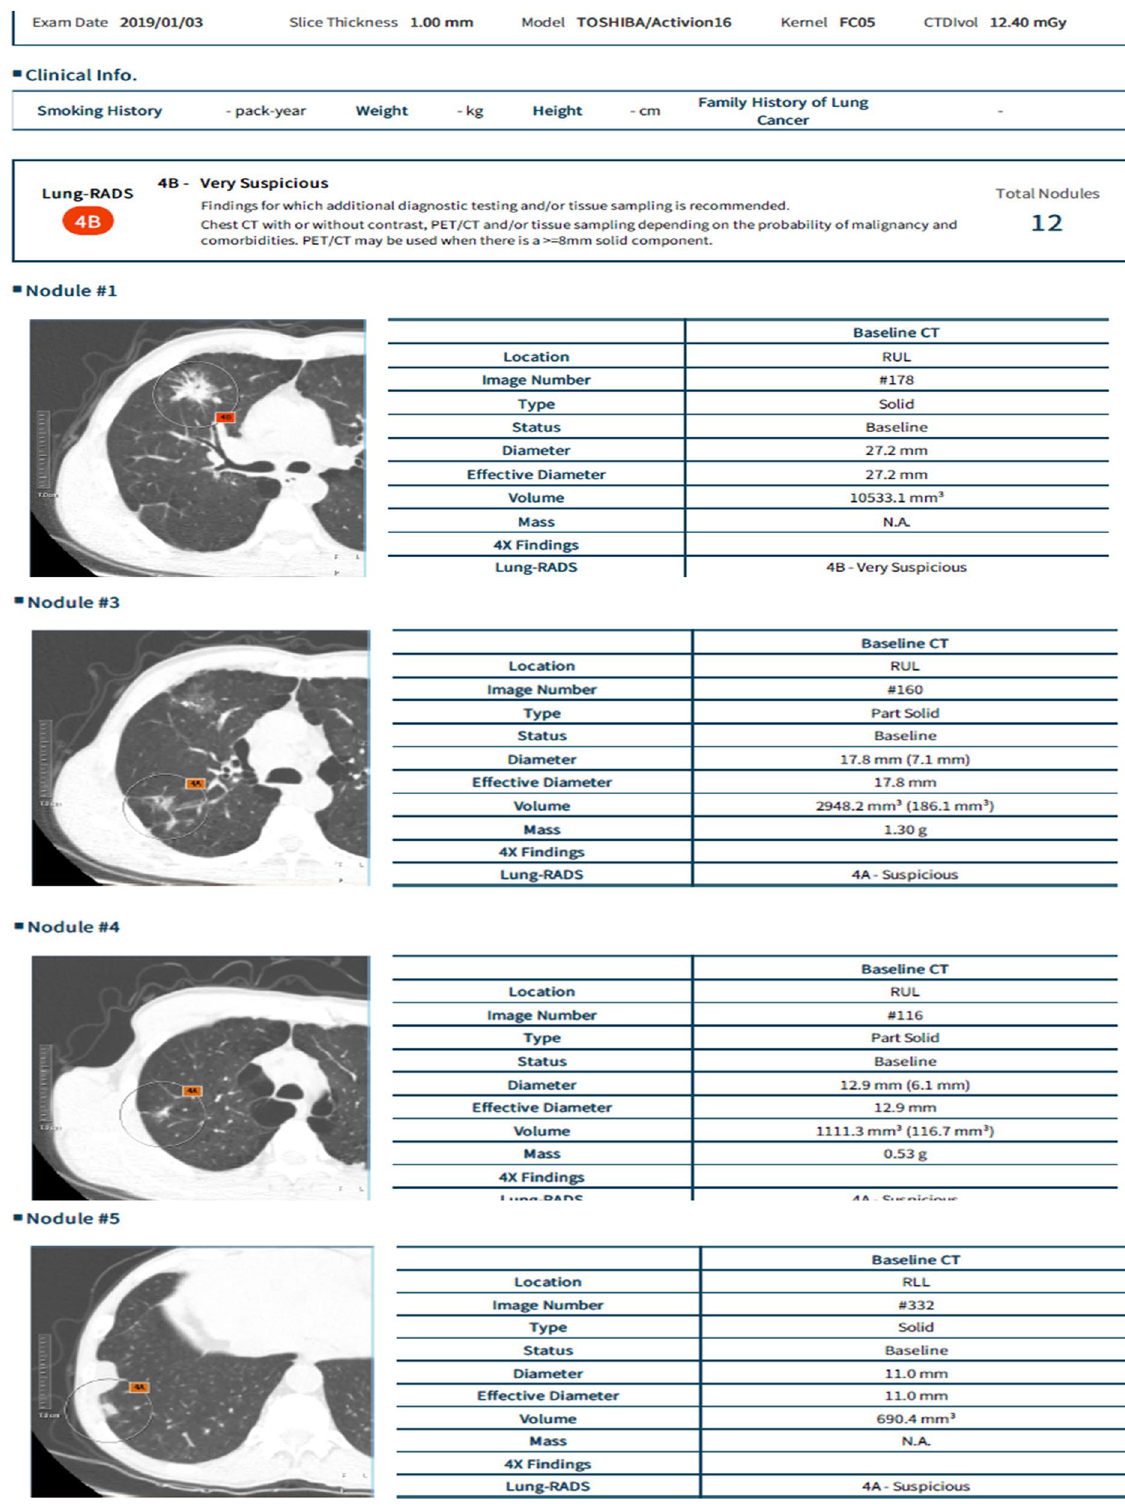
Fig. 5 Automated final lung cancer screening report as generated by the CAD